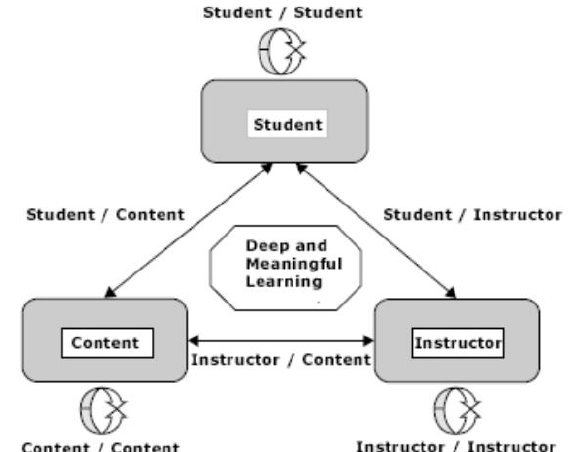
Figure 5. Interaction alternatives in distance education (Anderson,